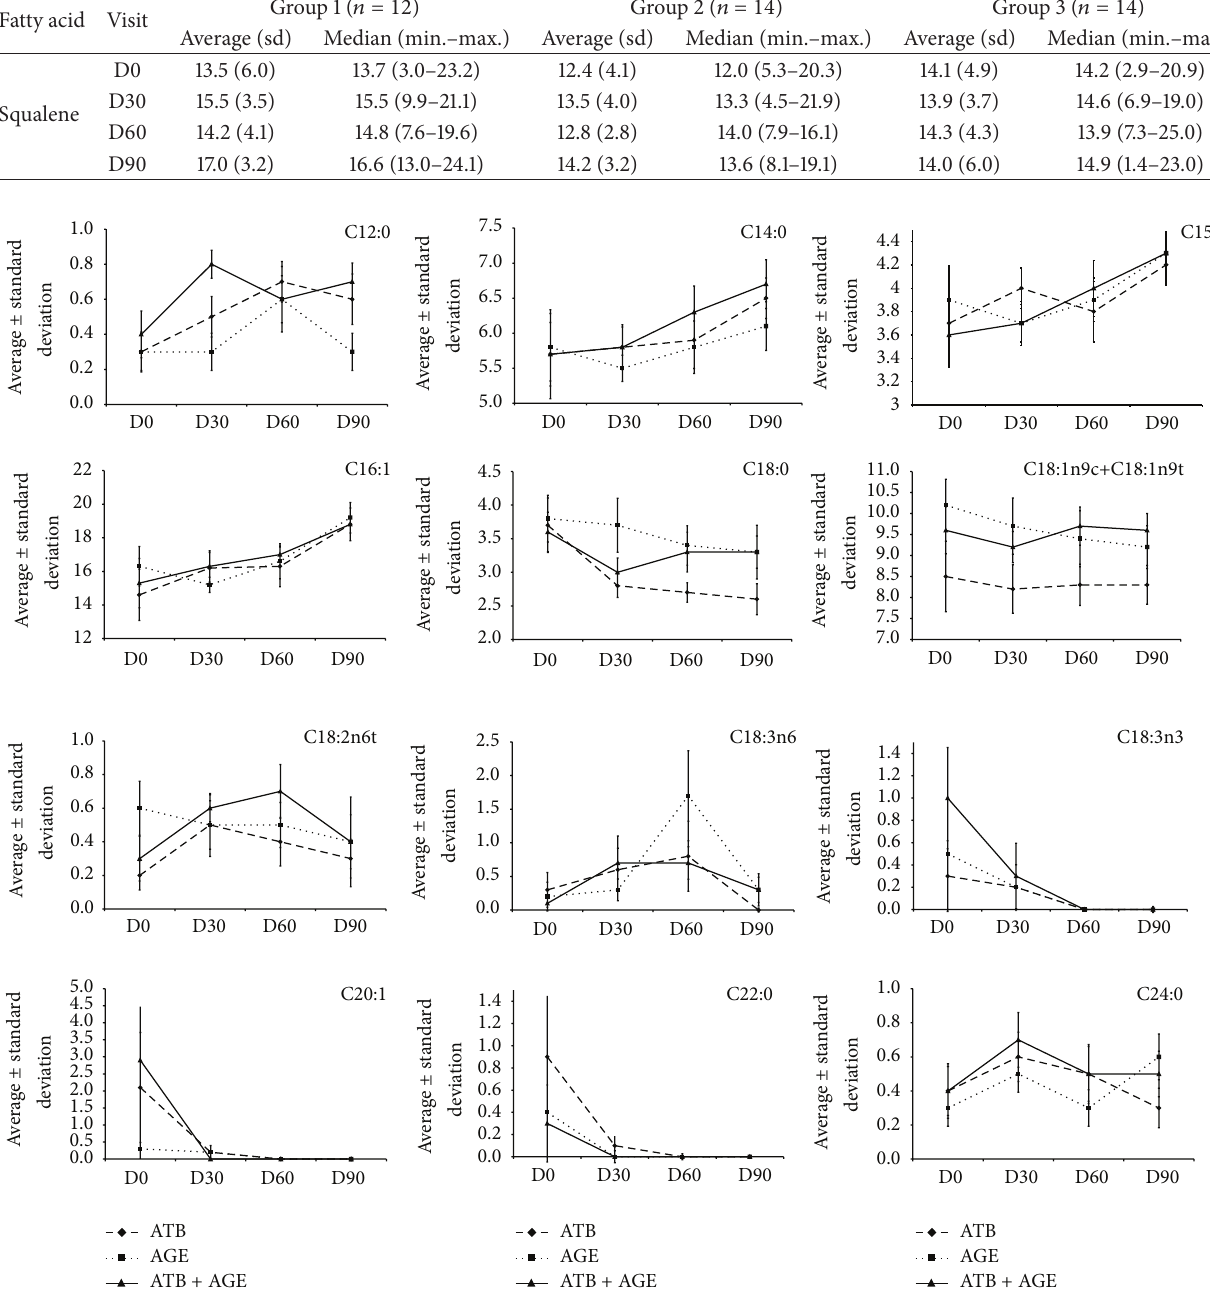
Table 3: Quantitative squalene variation during the study, based on group treatment and visit. Fatty acid Visit